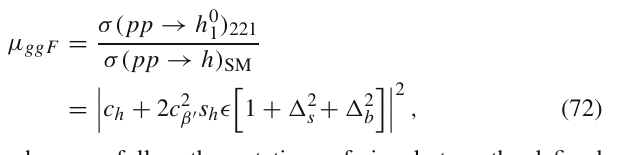
couplings , where